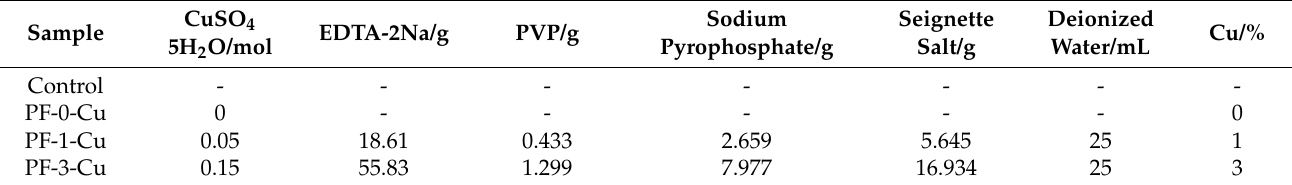
Table 1. The main compositions prepared for nano-copper modified phenol-formaldehyde (PF) resin.